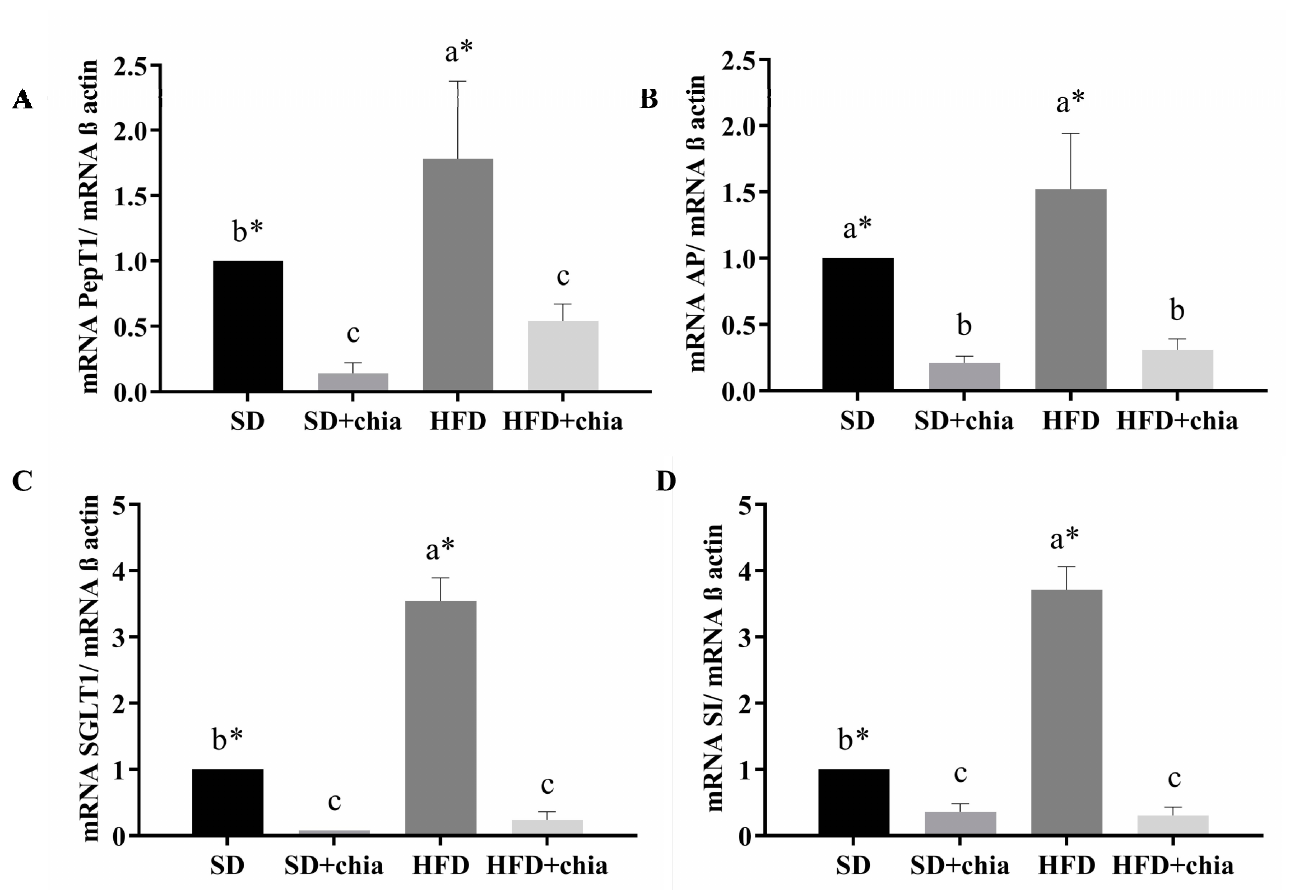
Figure 6. Gene expression of brush border membrane functional proteins in the intestinal tissue.